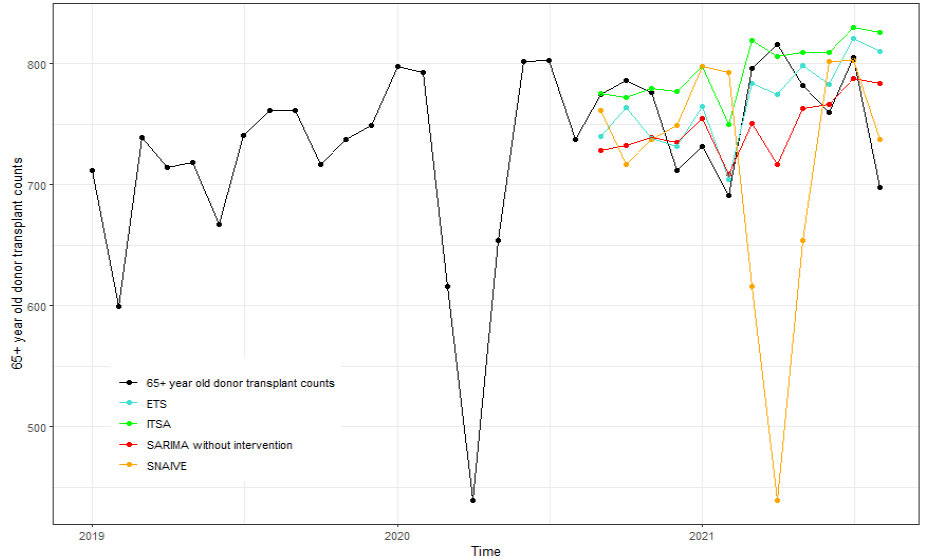
Figure 11. Forecasts of all donor transplant counts for the 65+-year-old from September 2020 to August 2021 using ITSA, SARIMA without intervention, ETS, and SNAIVE. Table 5. Forecast accuracy measures by age group at various forecast